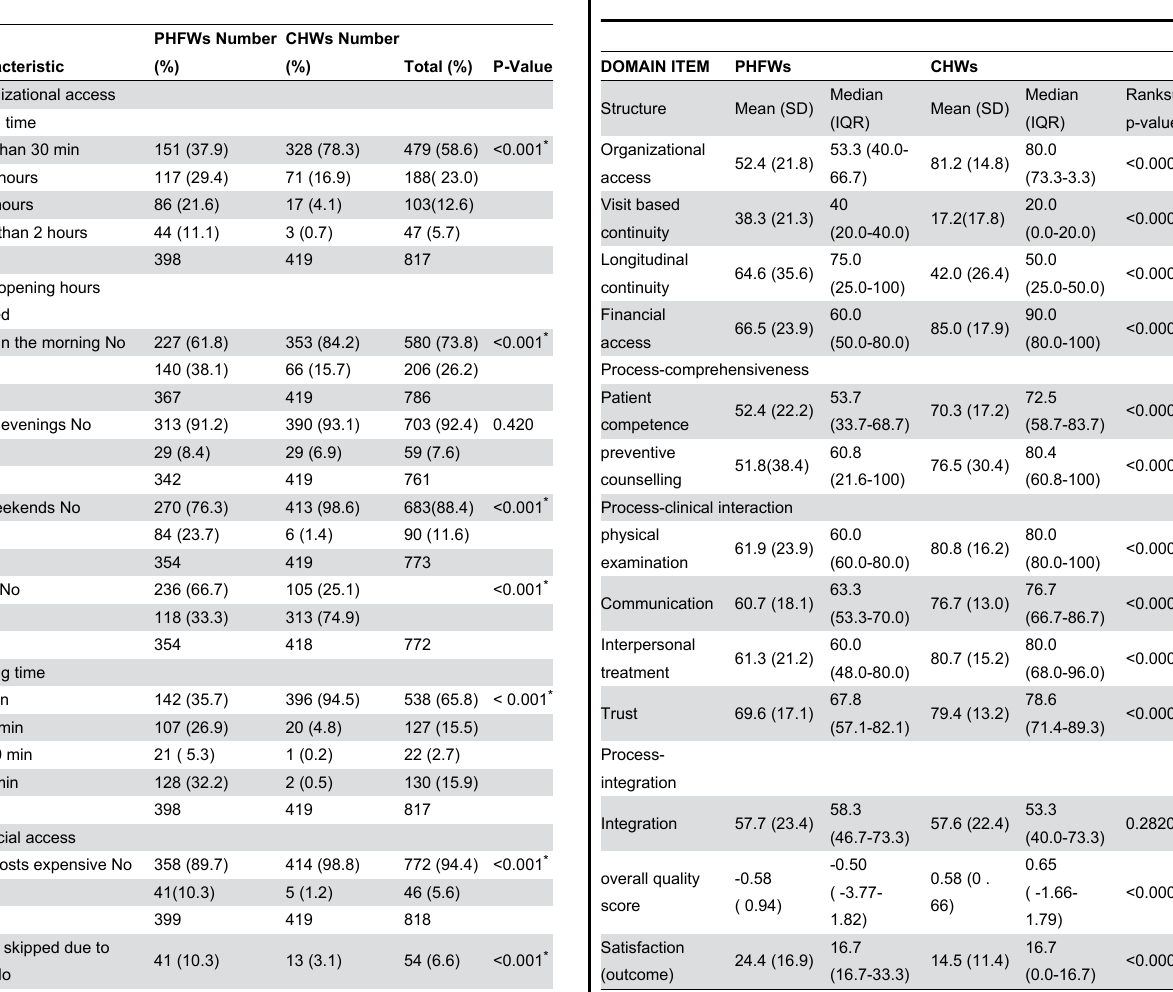
Table 3. Association between access measurements and service providers.